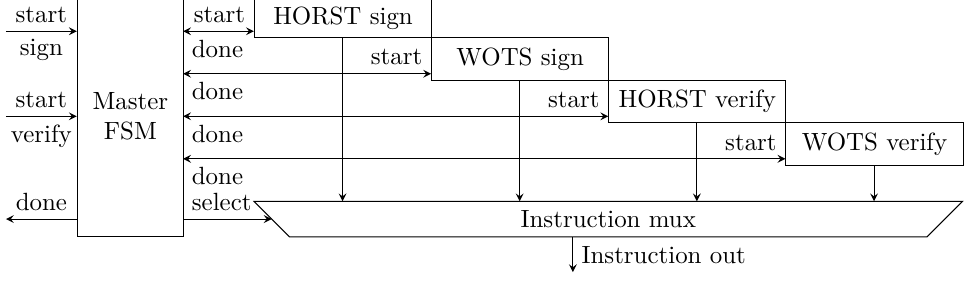
Figure 4: A Master FSM controls several slave FSM to reduce the number of states in one